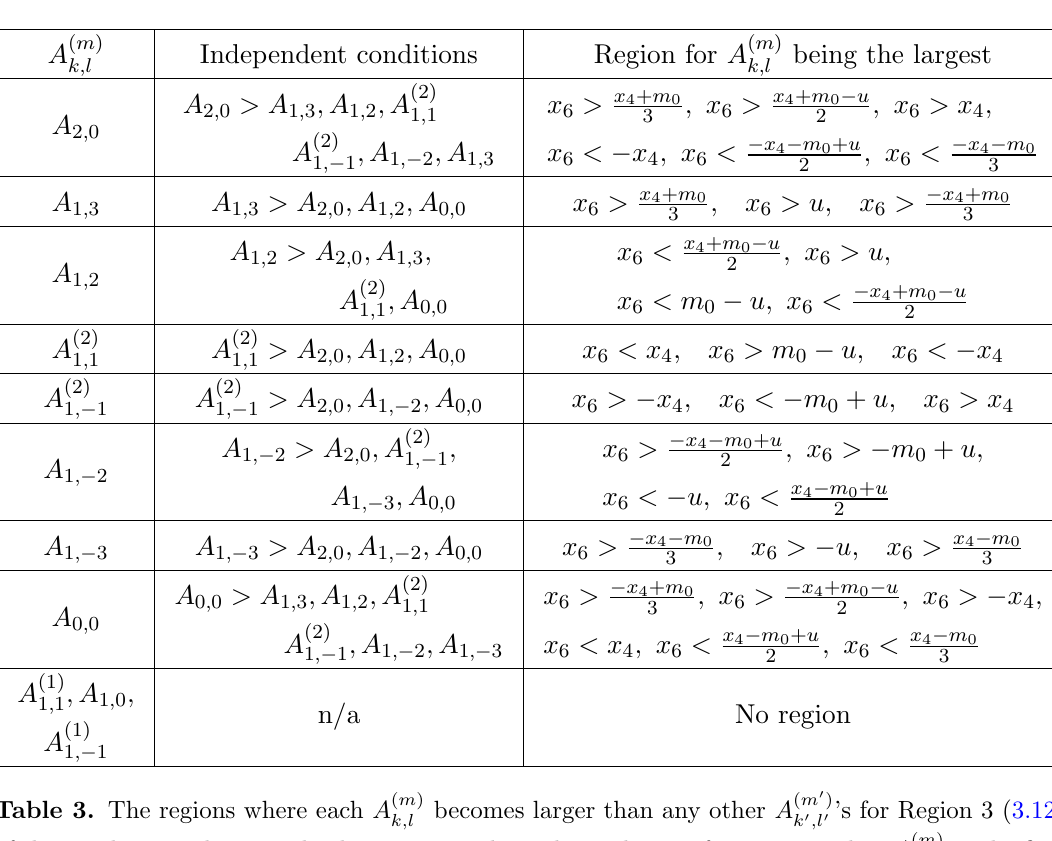
becomes larger than any other A ( m k;l